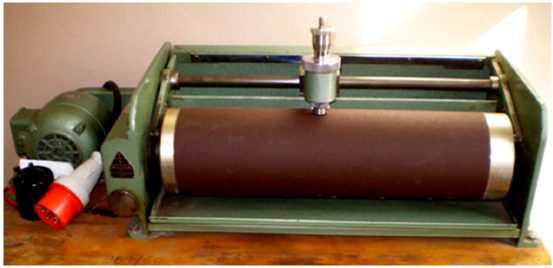
Figure 2. Scheme of APGi test device with abrasive cloth.